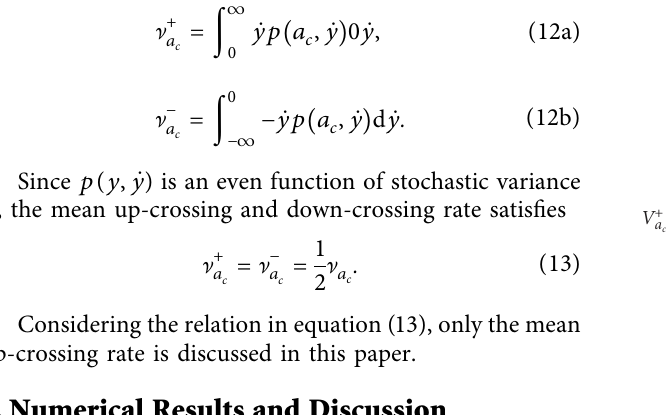
Figure 11: The mean up-crossing rate υ + (b) MCS results.